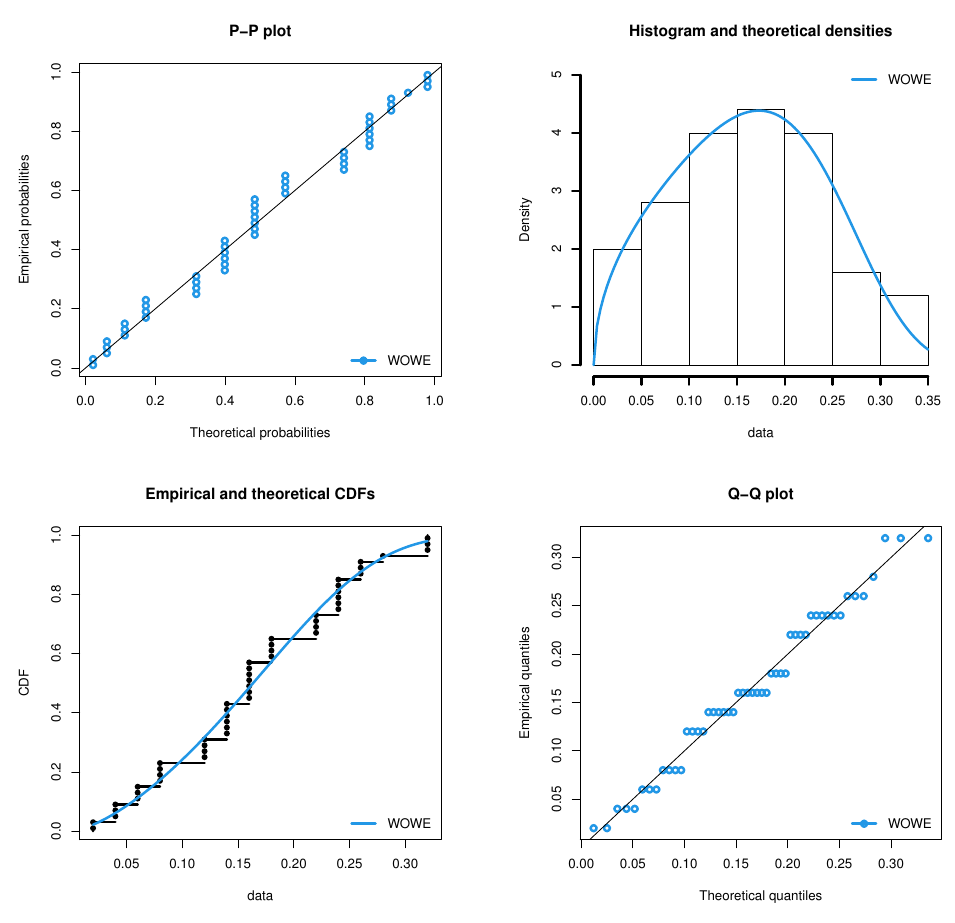
Figure 3. Plots of four estimated objects for the drilling machine